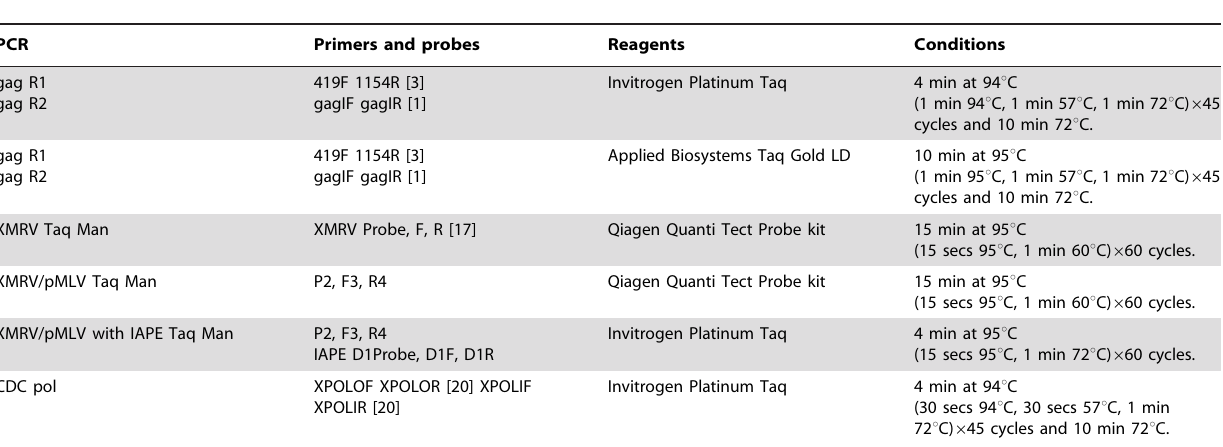
400 nM concentrations of primers and 200 nM probes were used in all the TaqMan assays. doi:10.1371/journal.pone.0019953.t001 PLoS ONE |